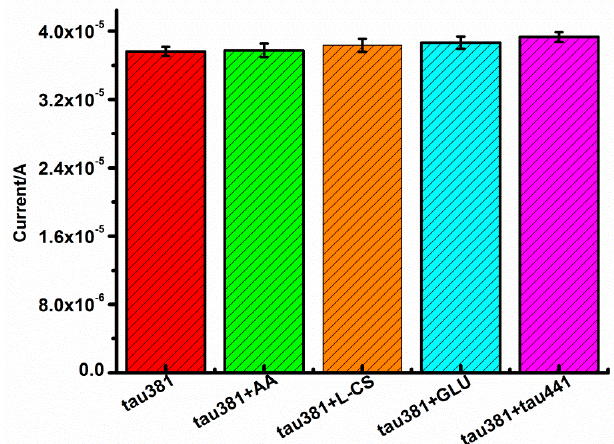
Figure 6. Current response of the aptasensor to 1 pM tau381, 1 pM tau381 + 100 pM AA, 1 pM tau381 + 100 pM L-CS, 1 pM tau381 + 100 pM GLU, 1 pM tau381 + 100 pM tau441 (n > 3).